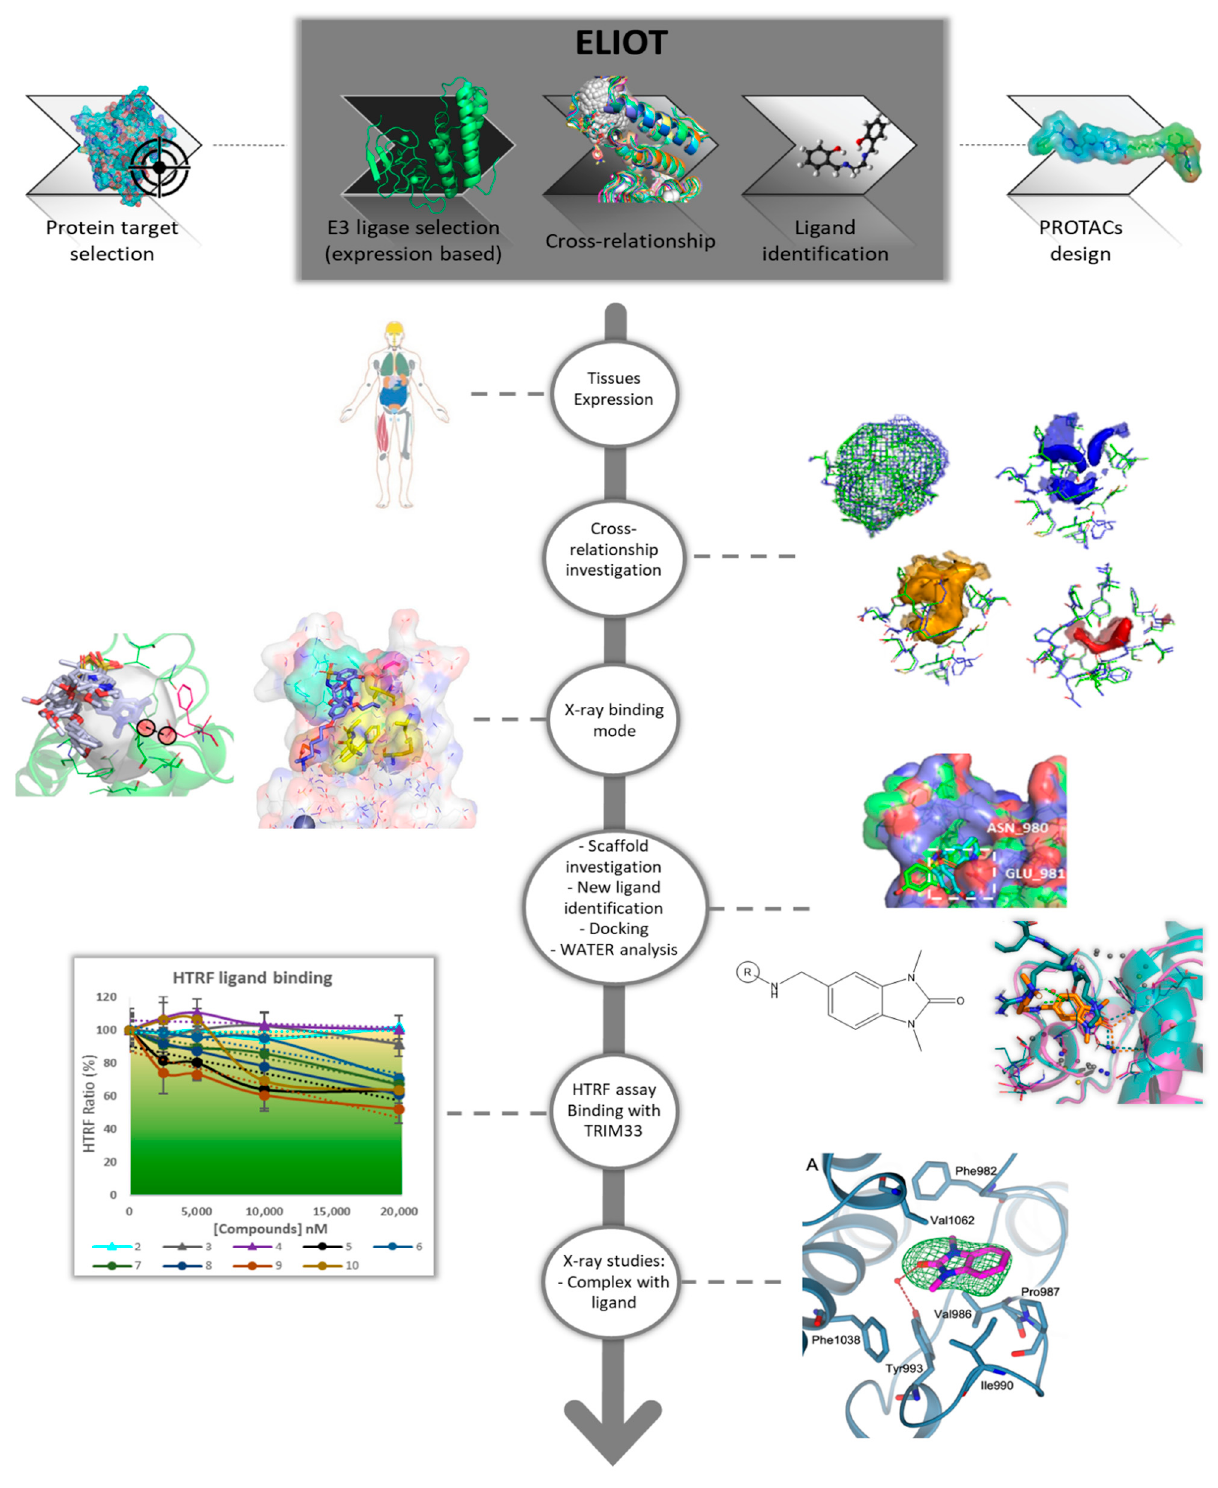
Figure 1. Workflow from ELIOT to identify scaffold-repurposing opportunities: a strategy to exploit the MIF-based cross-relationship between the E3 ligase pockets to identify new ligands of a novel E3 ligase.